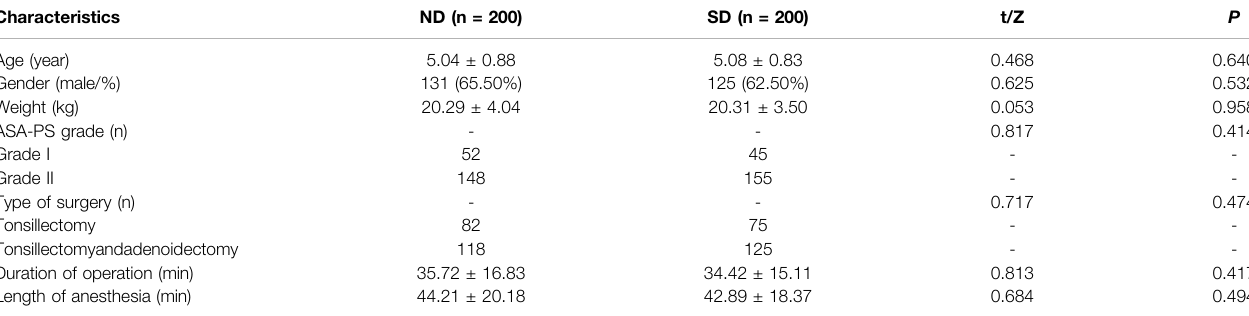
TABLE 1 | Patient characteristics between Group ND and Group SD.